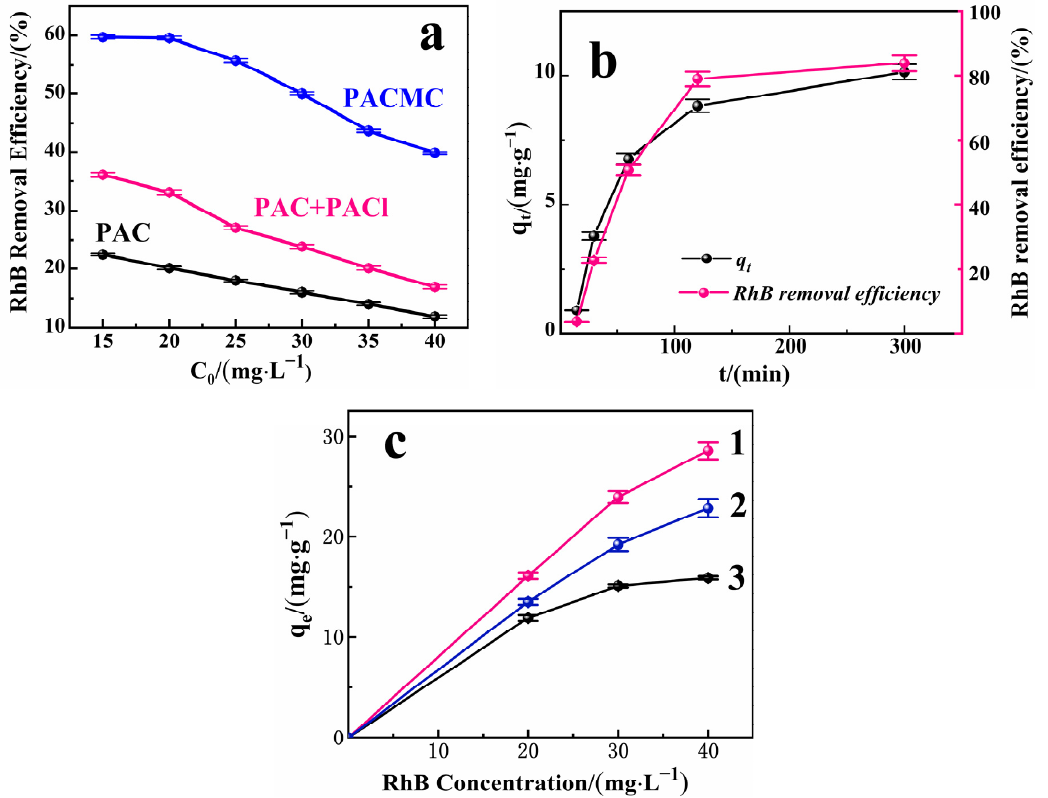
Figure 9. ( a ) Influence of initial RhB concentration for removal efficiency of RhB on PAC, PAC+PACl, and PACMC (Adsorbent mass: 1 g·L − 1 , Temperature: 20 °C, pH = 6.88, Reaction time: 24 h); ( b ) Influence of reaction time for the adsorption capacity ( q t ) and removal efficiency of RhB on PACMC ( C 0 = 20 mg·L − 1 , Adsorbent mass: 1 g·L − 1 , Temperature: 20 °C, pH = 6.88); ( c ) Influence of solution pH for the adsorption of RhB on PACMC 1—pH = 4.5; 2—pH = 9; 3—pH = 7 ( C 0 = 20, 30, 40 mg·L − 1 , Adsorbent mass: 1 g·L − 1 , Temperature: 20 °C, Reaction time: 24 h).